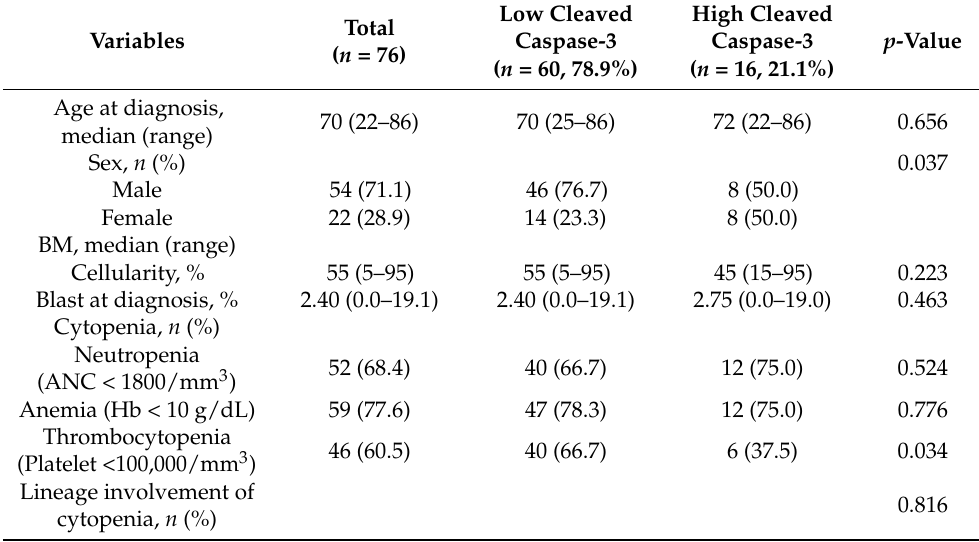
Table 1. Patient